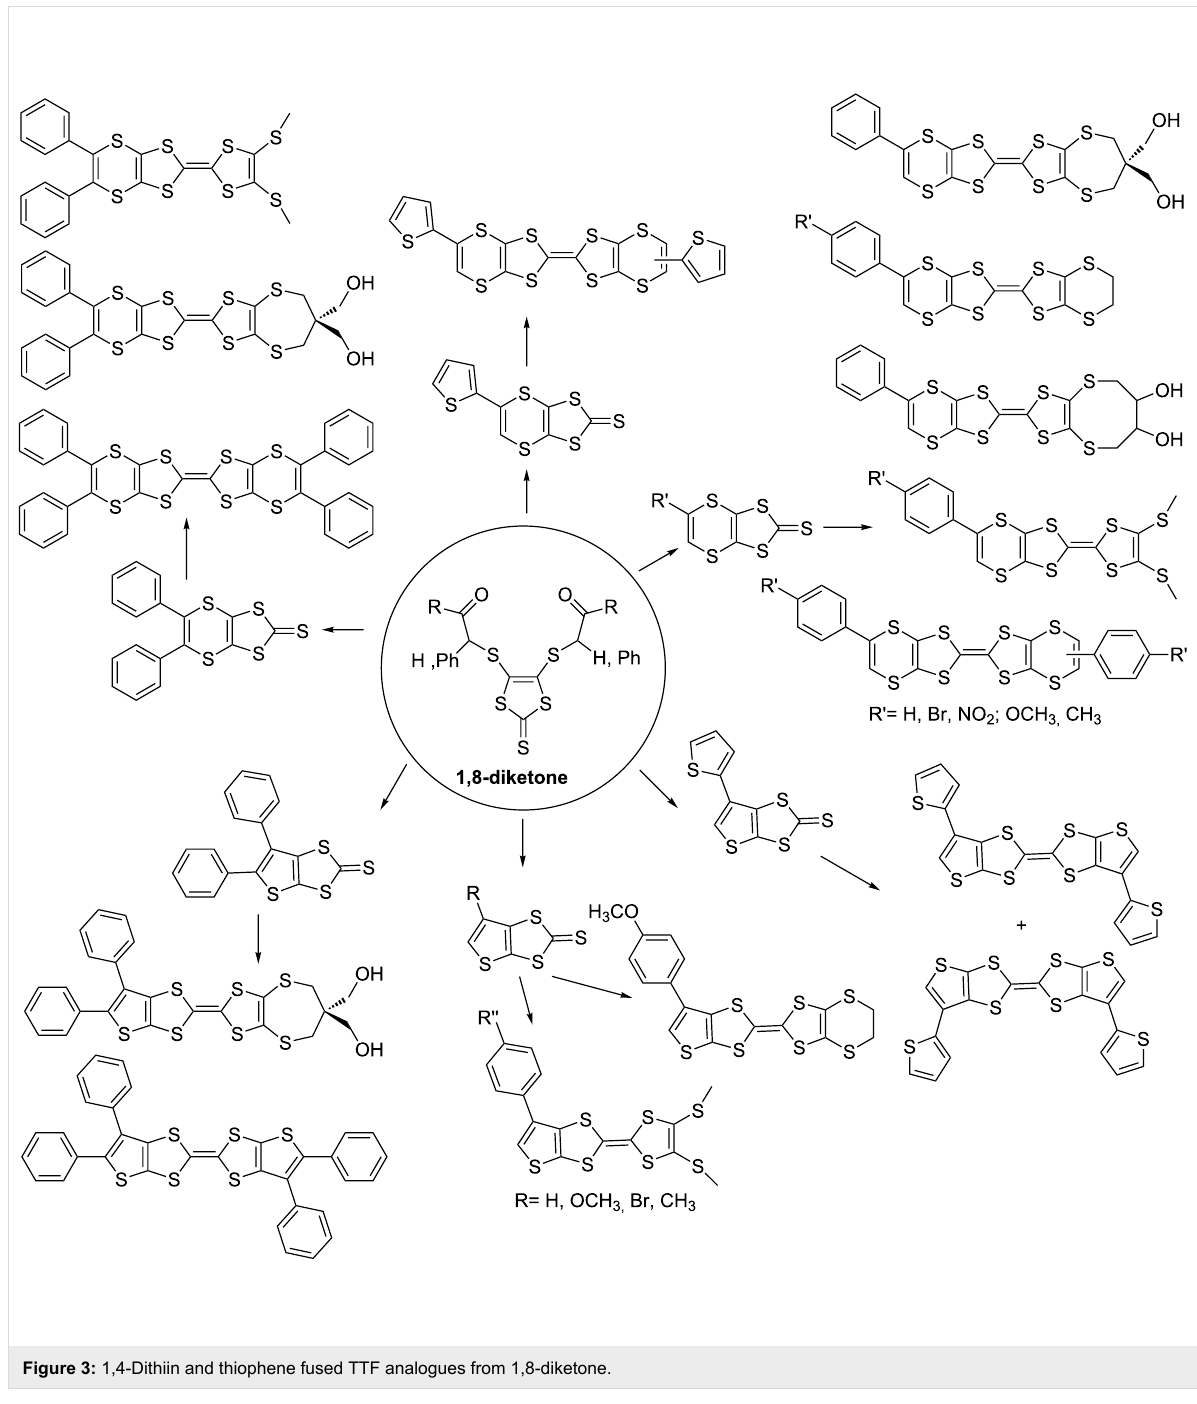
the formation of enethiols 8 , a tautomer of 7 , then nine- membered ring 9 , rearrangement of which produces 10 . Lastly, the reaction of 10 with fragment 14 of LR would give 11 as a major product (Scheme 1). Rearrangement of the 1,4-dithiin unit of 11 would produce 13 as a minor product through the intermediate 12 by the loss of elemental sulfur. The reaction of a series of 1,8-diketones with LR 15 or P 4 S 10 was further